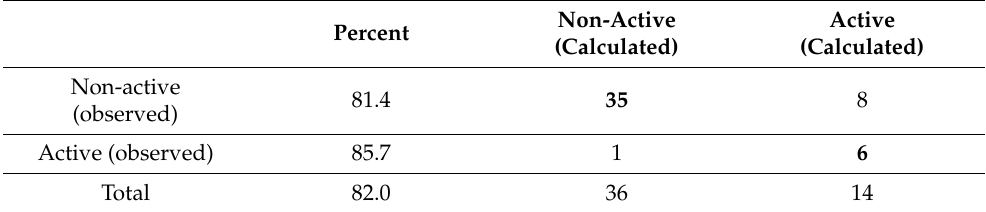
Non-Active Percent (Calculated)